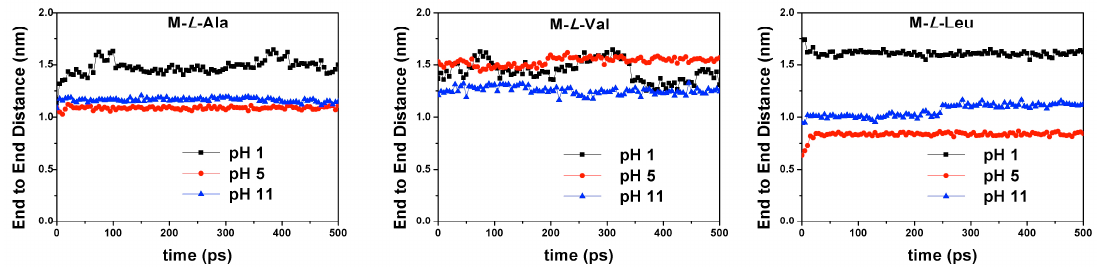
Figure 9. Time dependence of PAACs’ end-to-end distance within the MD run at different pH values.